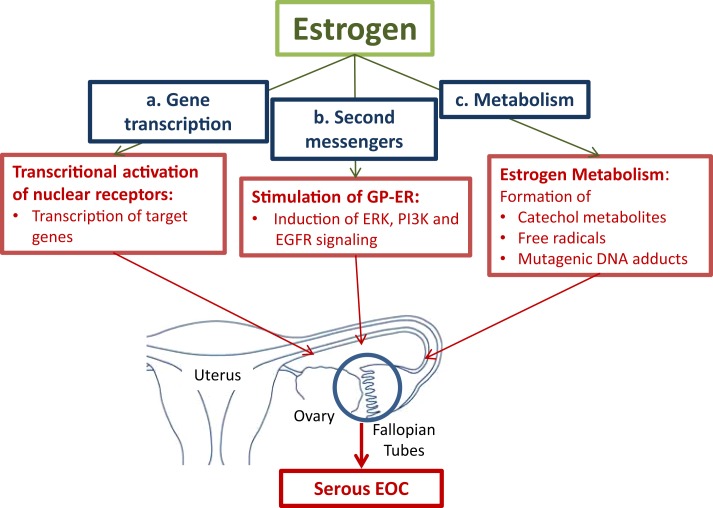
Pathways for estrogen to convert tumor promoting effects in cells in the fallopian tubes and the ovaries. (a.) Activation of the nuclear estrogen receptor-α (ER-α) leads to the transcriptional activation of estrogen-responsive genes, which stimulate cell proliferation. (b.) Binding to membrane-bound G-protein-coupled estrogen receptor (GPER) activates second messenger systems. In cancer cells, estrogen induces extracellular-signal regulated kinase (ERK), phosphoinositide 3-kinase (PI3K), and epidermal growth factor receptor (EGFR) leading to enhanced cell proliferation. (c.) The formation of reactive metabolites leads to the generation of mutagenic DNA adducts. Free radicals from the metabolic activation of estrogens will cause mutations. Accumulation of mutations will lead to neoplastic transformation of proliferating cells (10, 42, 44–46)